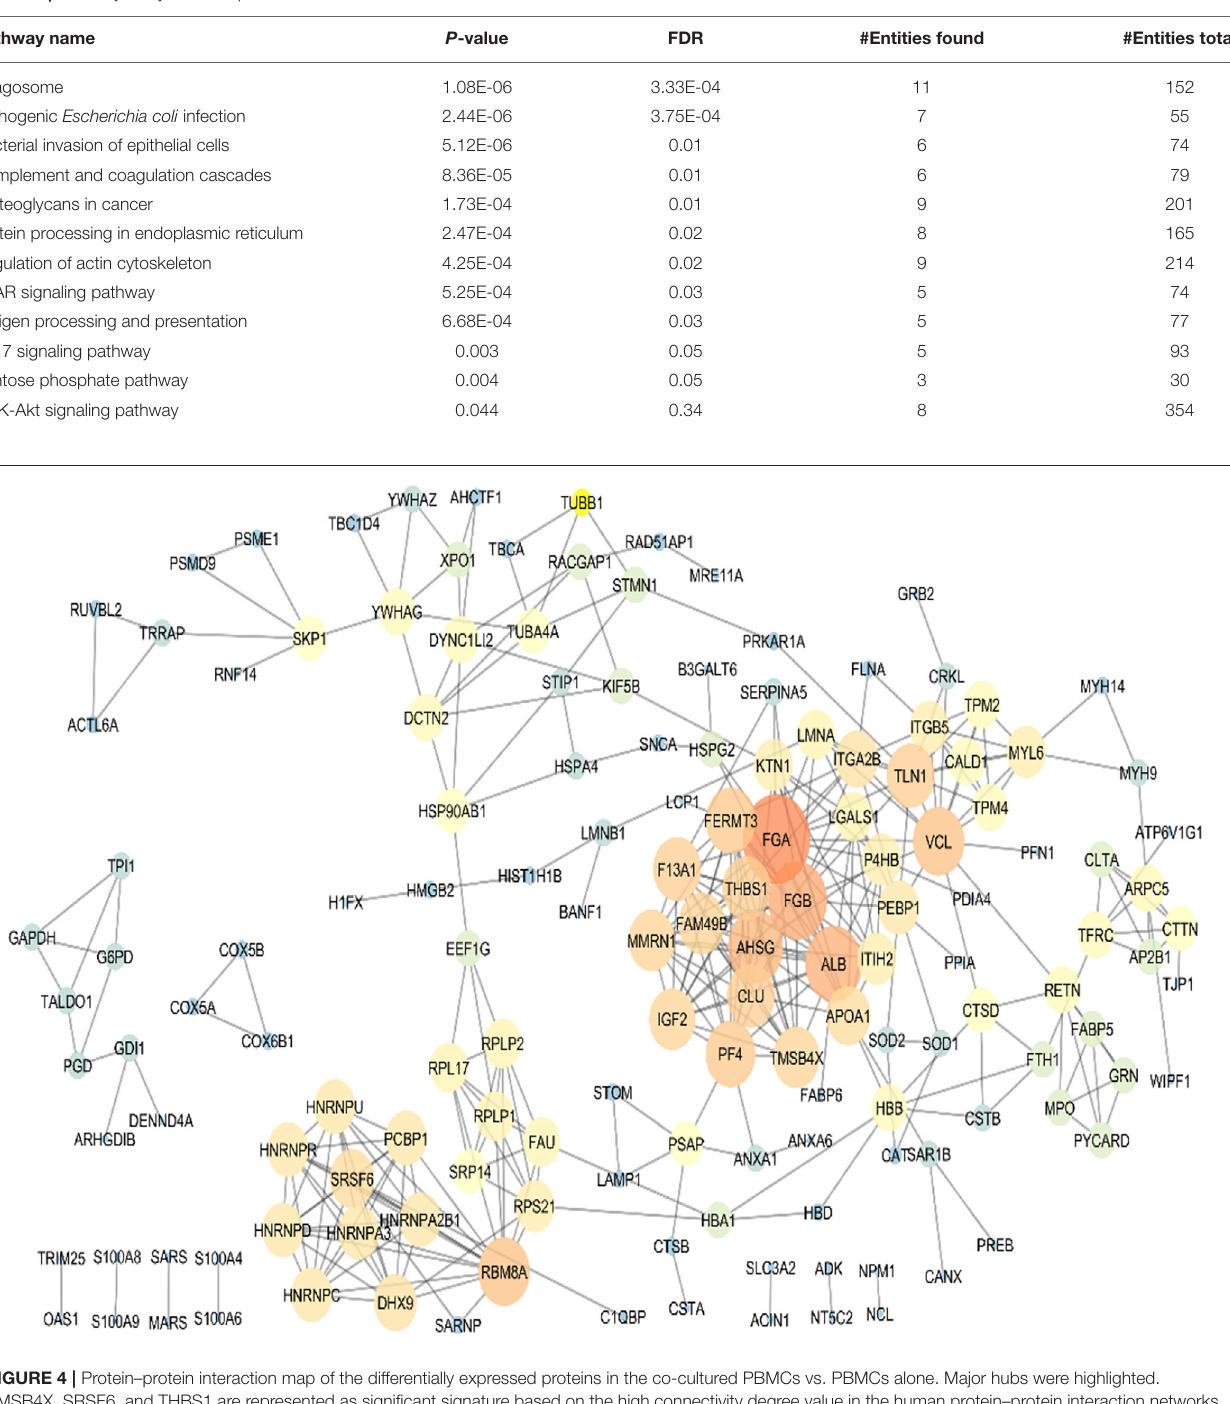
cancer, breast carcinoma, adenocarcinoma of the lung, and malignant neoplasm of the